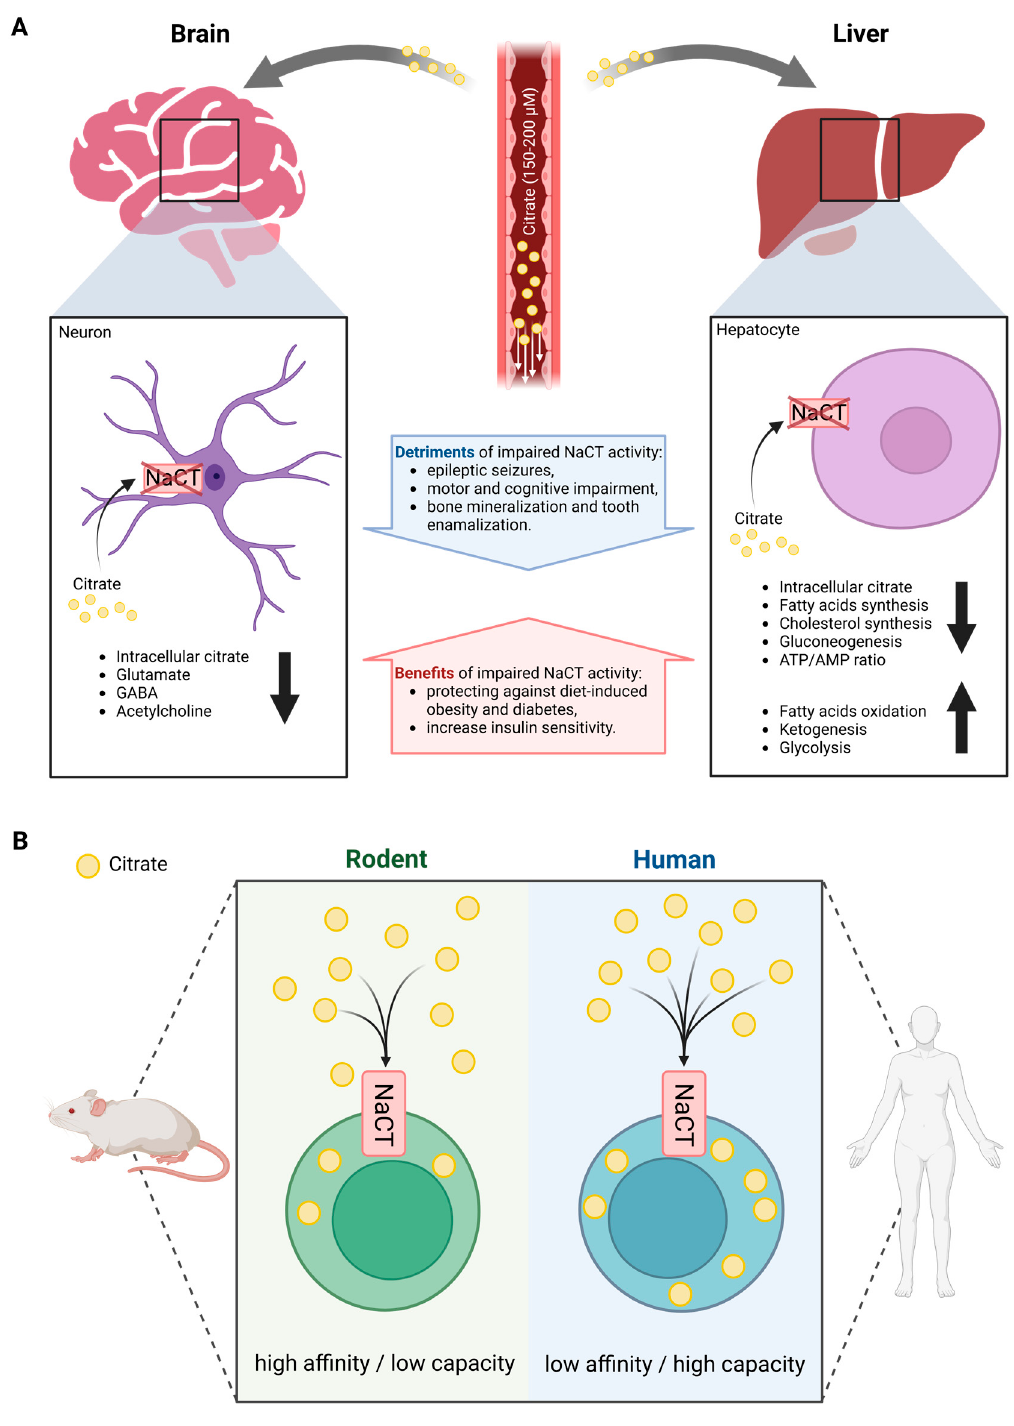
Figure 1. Overview of systemic citrate metabolism. ( A ) Organ-specific differences in phenotype outcomes of altered NaCT activity in mammals. ( B ) Species-specific differences in functional features of NaCT transport. (Created with BioRender.com).